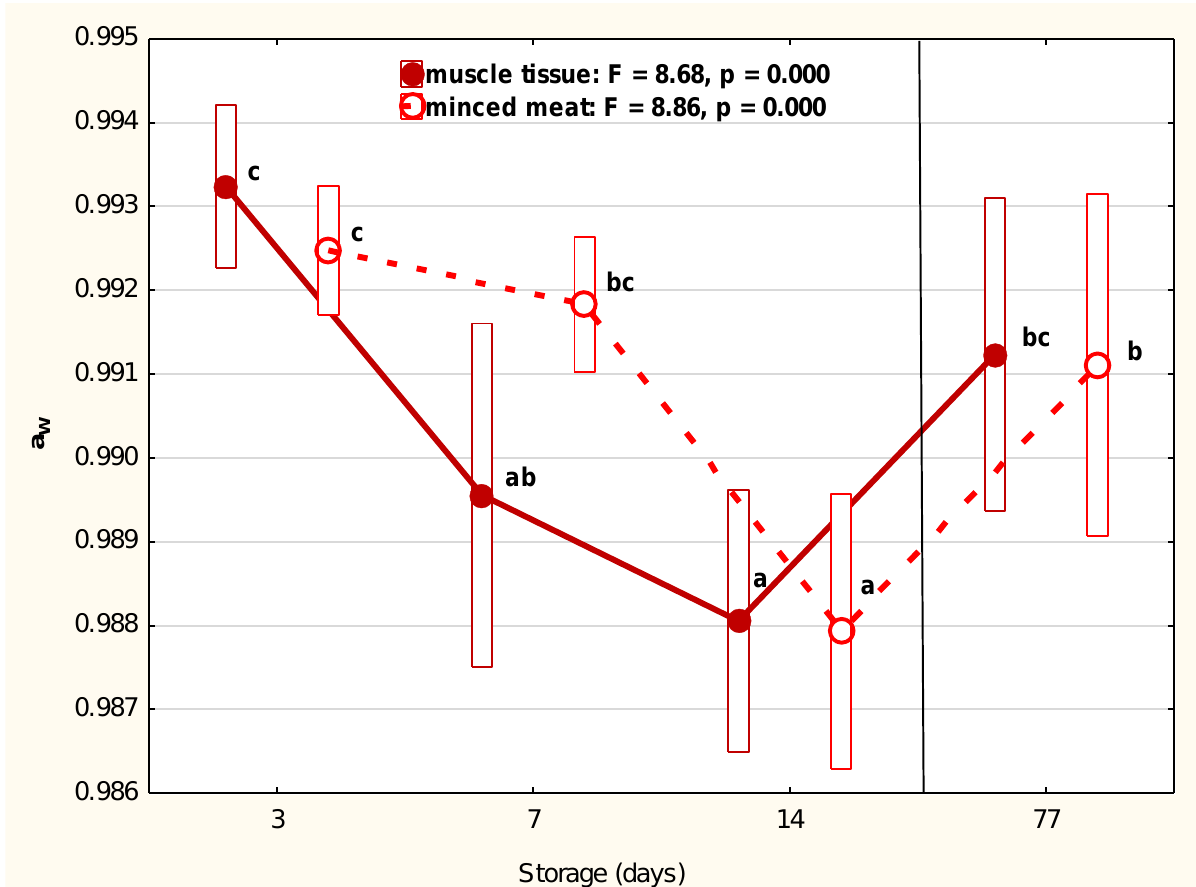
Figure 2. The water activity of muscle tissue and minced meat of beaver during storage. The a w of muscle tissue and minced meat of beaver during refrigerated (1, 7, 14 days) and frozen (77 days) storage. Red filled dots represent the average a w value of muscle tissue. The continuous line represents the trend in changes between storage days. The red empty dots represent the average a w value in minced meat. The dotted line represents the trend in changes between storage days. Bars represent the standard deviation. The mean values marked with letters (a, b, c) differ statistically at p ≤ 0.05.